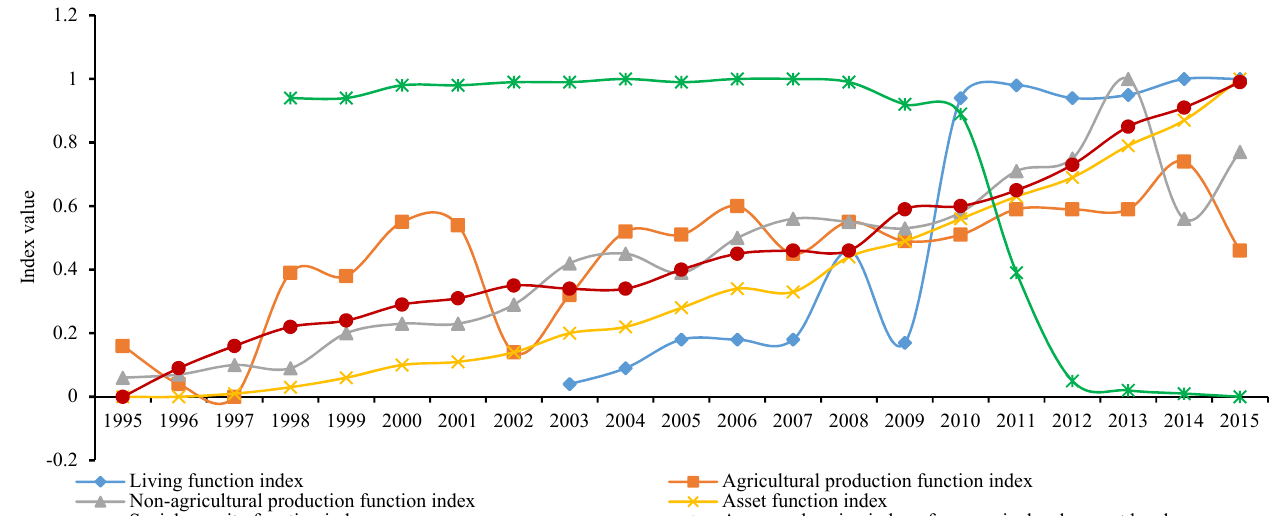
Figure 4. The evolution of rural-homestead function and the composite index of economic-development level from 1995 to 2015 in China. (1) The evolution of the living function of rural homesteads showed slow growth